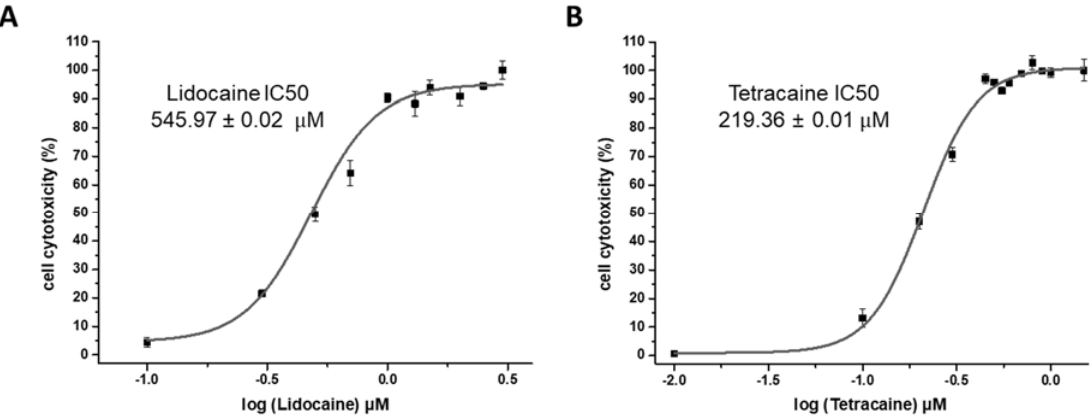
Figure 2. LDH (Lactate Dehydrogenase) assay to analyze cell cytotoxicity, ( A ) Lidocaine IC50 is 545.971 µM ( B ) Tetracaine IC50 is 219.36 µM. (n = 3, p < 0.001).